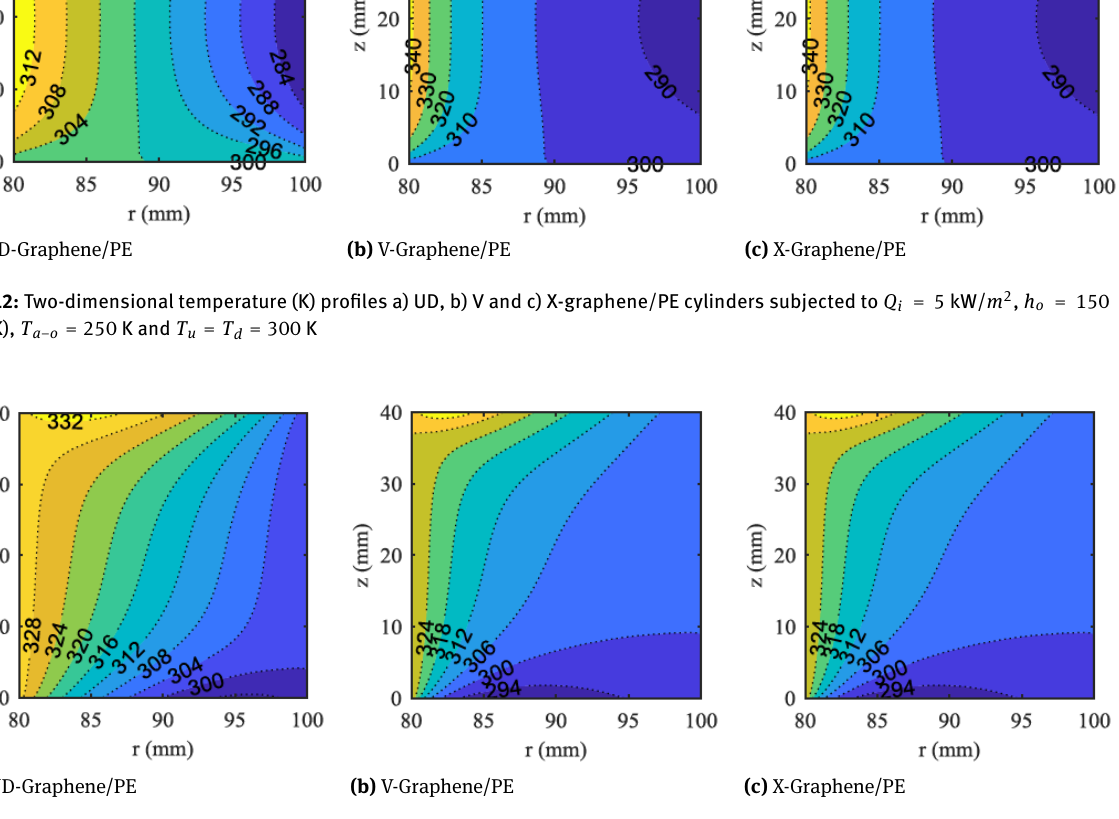
Figure 13: Two-dimensional temperature (K) profiles a) UD, b) V and c) X-graphene/PE cylinders subjected to T i = 330 K, T o = 300 K, Q u = 5 kW/ m 2 and Q kW/ m d = −5